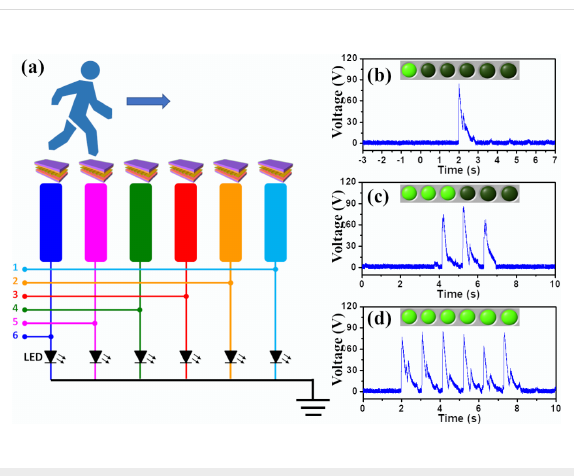
Figure 5: Self-powered u-TENG-based location-tracking system. (a) Circuit diagram of the fabricated u-TENG-based tracking system. (b–d) Measured output voltage and real-time location mapping when the pedestrian arrives at the (b) first, (c) third, and (d) sixth